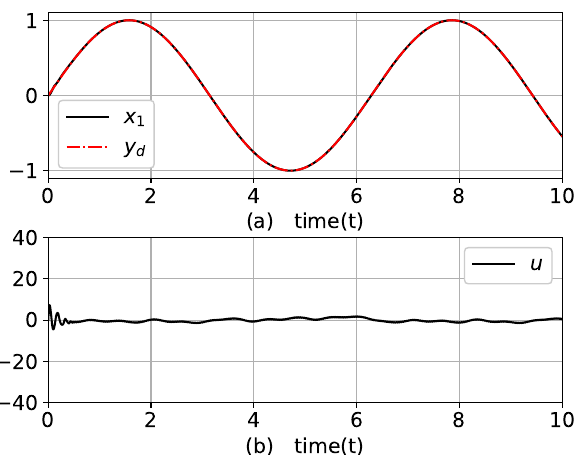
Figure 4. In the case of x ( 0 ) = [ 0,0.1 ] T ( a ) y and y d ( b ) control input u